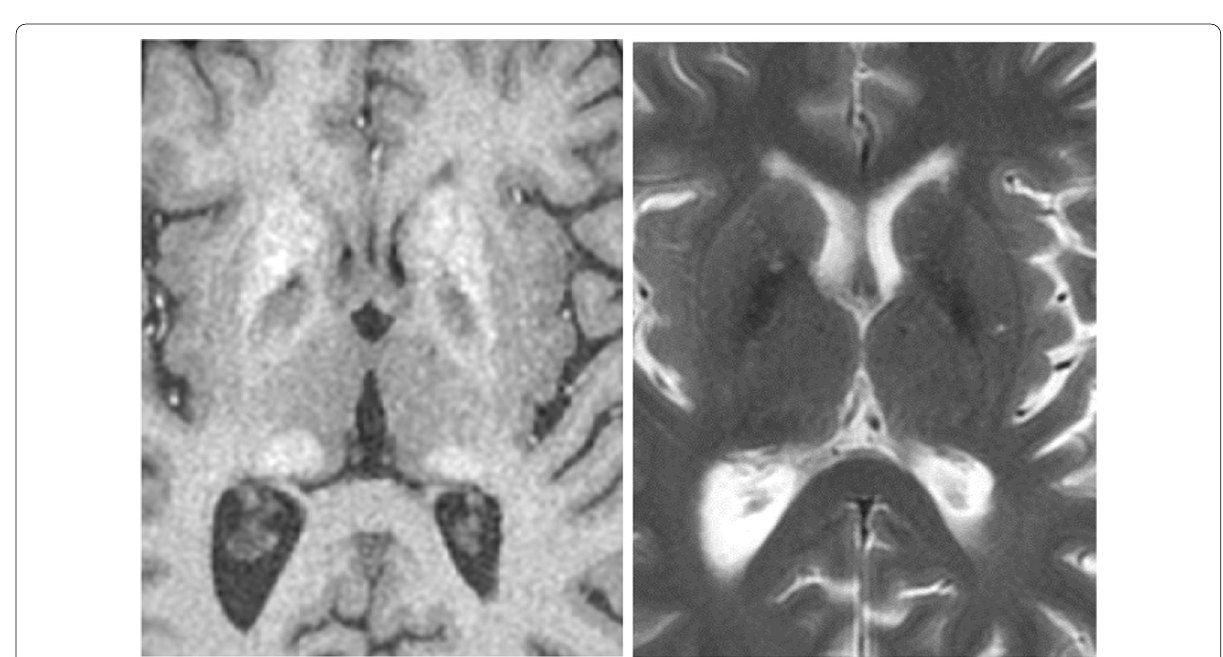
Fig. 2 a Magnetic resonance axial sections T1 spin-echo sequence showing areas of hyperintense signal in thalami and hypointense signal in pars medialis of the globus pallidus, b axial T2 spin echo hyposignal in pars medialis of the globus